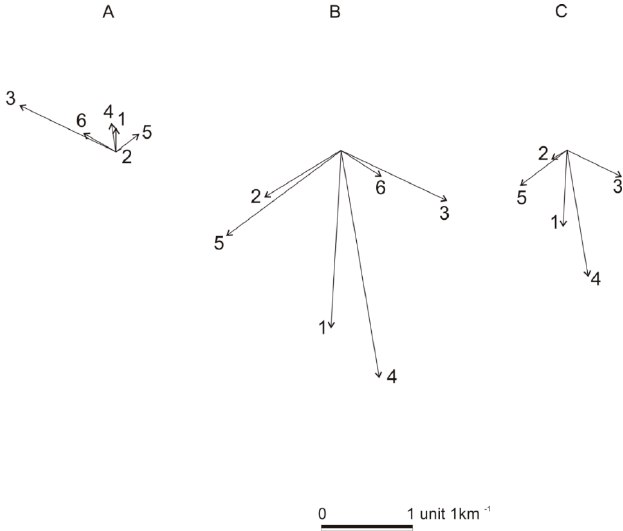
Figure 6. Average gradients of: ( A ) Chl-a; ( B ) DO; and ( C ) pH.